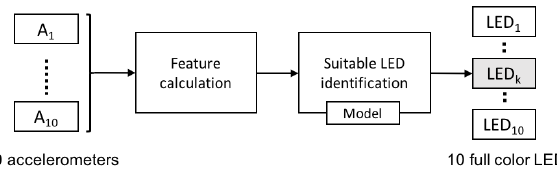
Figure 1. Functional components of experimental prototype